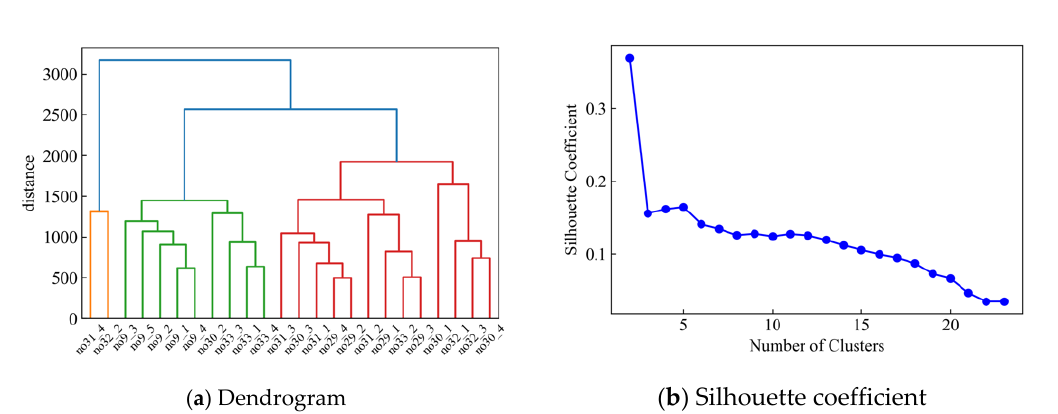
Figure A1. Clustering results of 24 standing behaviors from chair, sofa, and nursing bed using Ward’s method .